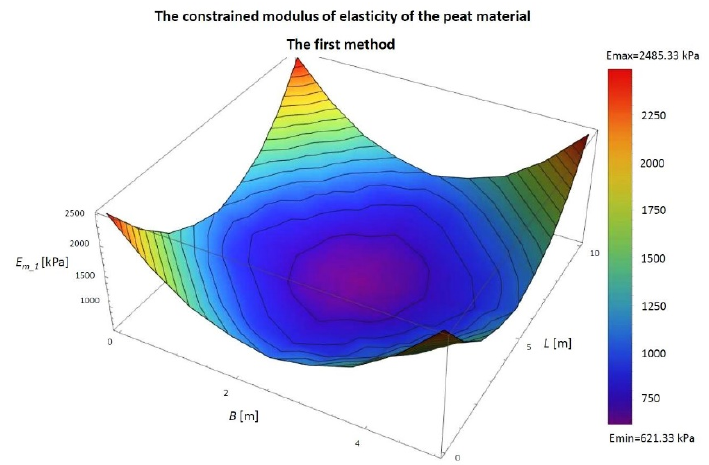
Figure 11. The first model determines the constrained modulus of elasticity of the peat material. B , width of the embankment (m); L , length of the embankment (m); E m_1 , constrained modulus of elasticity of peat material in the column under consideration, determined by the first model (kPa).